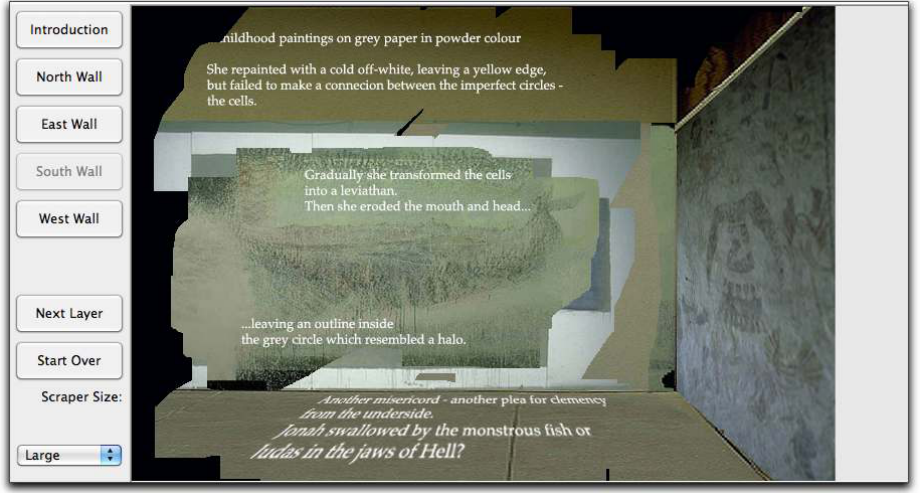
Figure 8: sample from Pentimento, by Jerome Fletcher, Geoffrey Olsen, Toby Holland